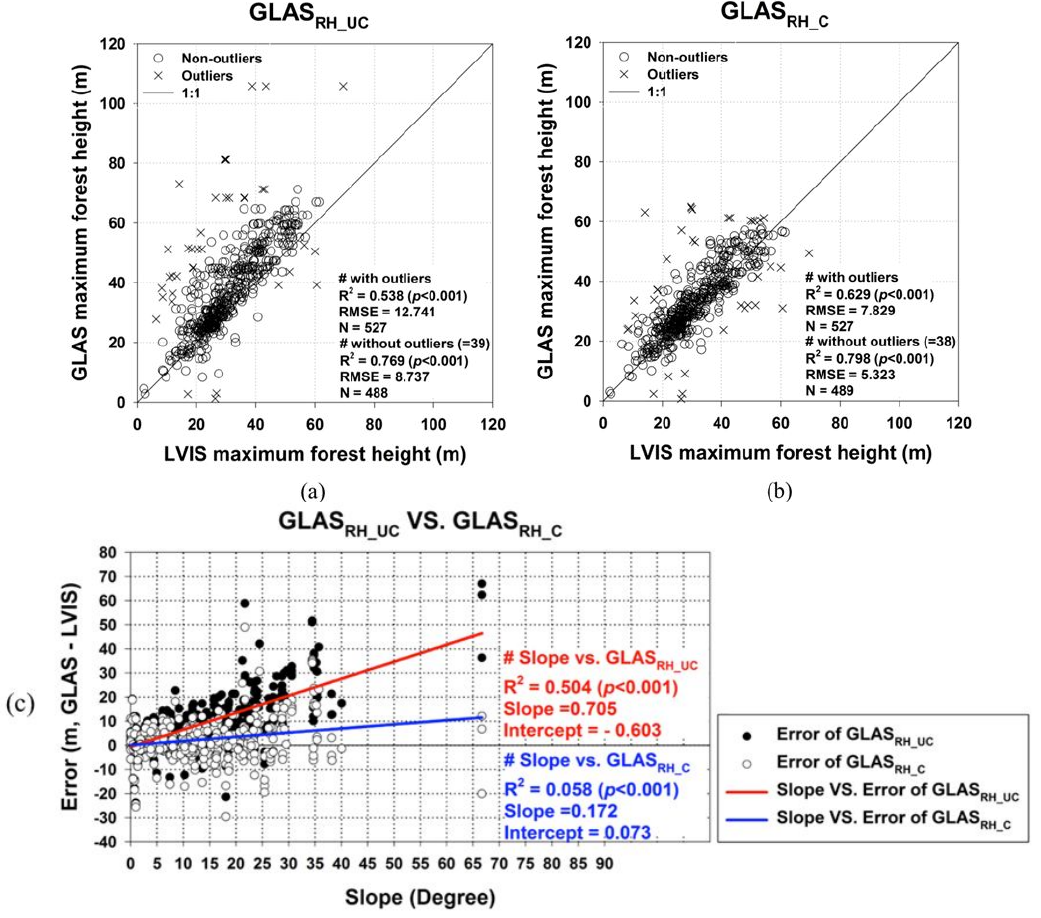
Figure 5. Comparisons of ( a ) uncorrected (GLAS ); and ( b ) corrected (GLAS ) RH_UC RH_C GLAS metrics against LVIS derived maximum forest canopy heights. Outliers are determined by Cook’s distance threshold (within three times the mean Cook’s distance); ( c ) Distribution of GLAS height errors by slope gradients. Filled markers with red fitted , while unfilled markers with blue fitted line line represent errors for GLAS RH_UC correspond to errors for GLAS . RH_C